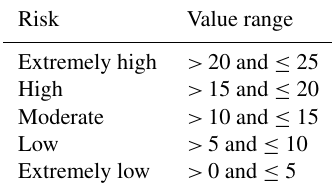
Table 3. Risk map value